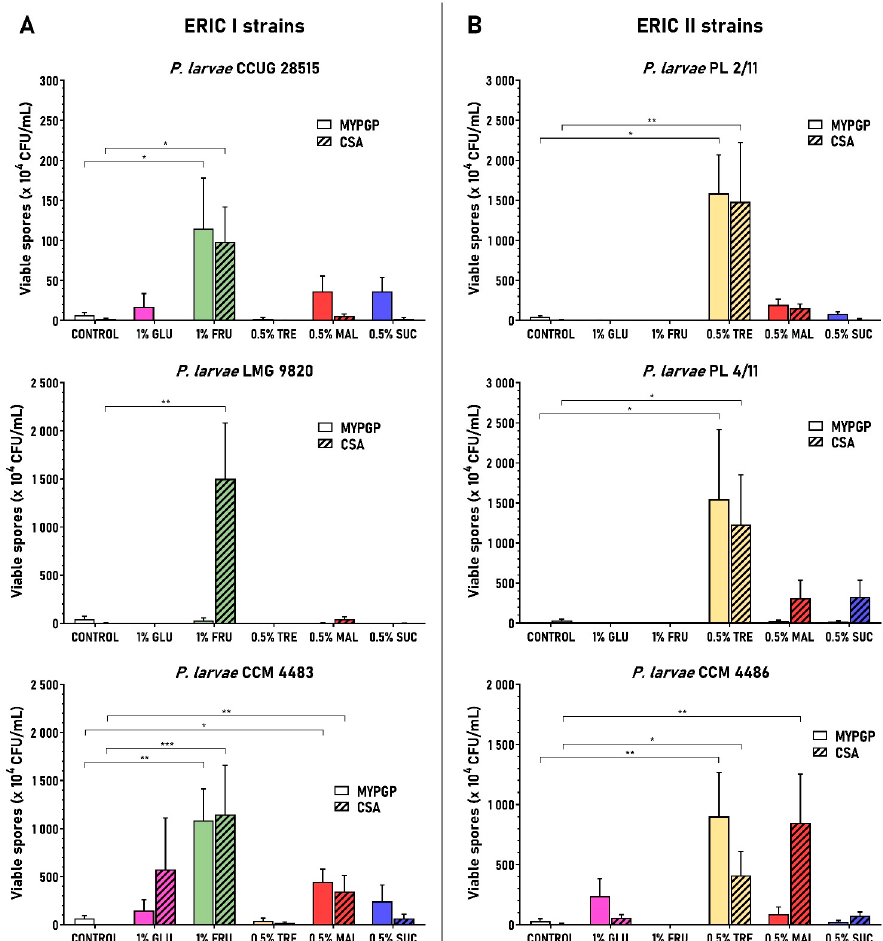
Figure 2. Effect of different saccharides on sporulation of the P. larvae ERIC I strains ( A ) and ERIC II strains ( B ). Strains were cultivated on MYPGP and CSA plates containing individual saccharides at 0.5% or 1% concentrations. The spore yields obtained with different saccharides are depicted in columns with different colours. Controls (without colour) represent yields obtained on plates not containing the saccharides. Spore yields are expressed as the mean ± SEM. Data showing statistical significance are marked (* p < 0.05, ** p < 0.01, *** p < 0.001). The number of replicates for the different spore cultivations were as follows: ( A ) MYPGP plates: controls n = 8, saccharide + n = 6–7; CSA plates: controls n = 7, saccharide + n = 5–6; ( B ) MYPGP plates: controls n = 6–7, saccharide + n = 4–6; CSA plates: controls n = 5–7, saccharide + n = 4–6.